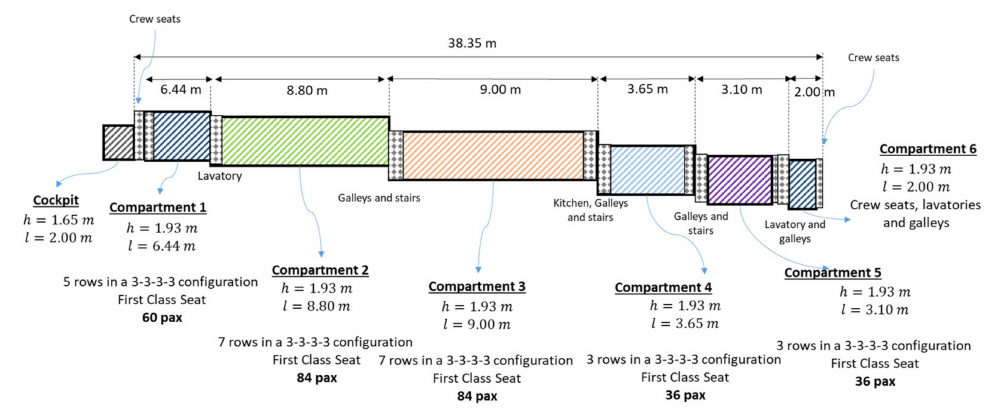
Figure 11. Artistic impression of the passenger cabin with main configuration data.